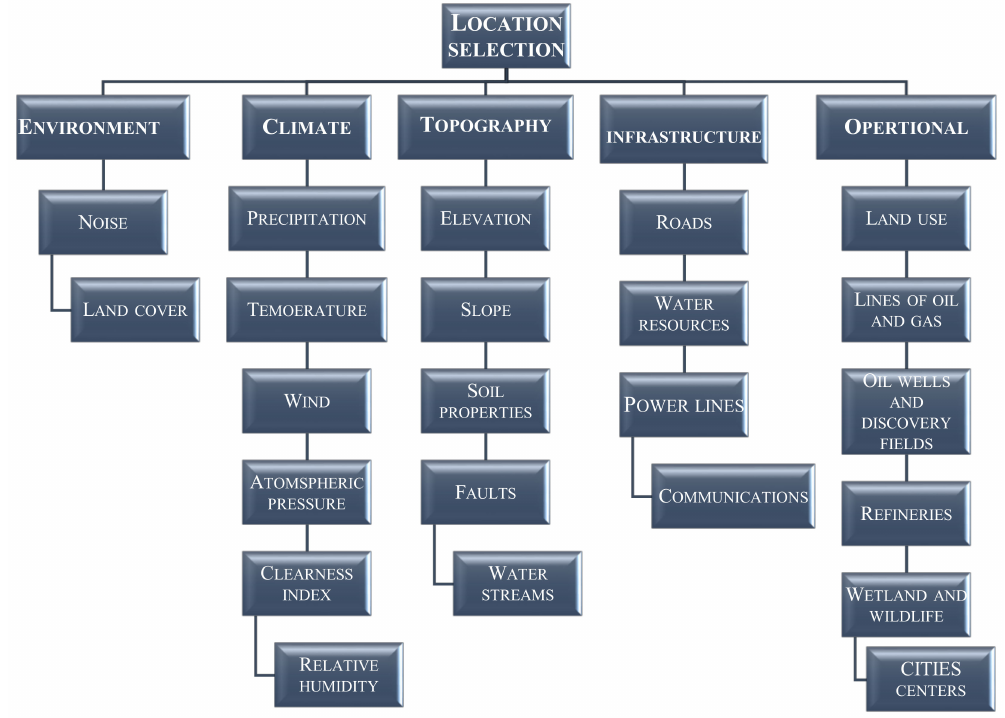
Figure 7. Hierarchy structure of the inputs